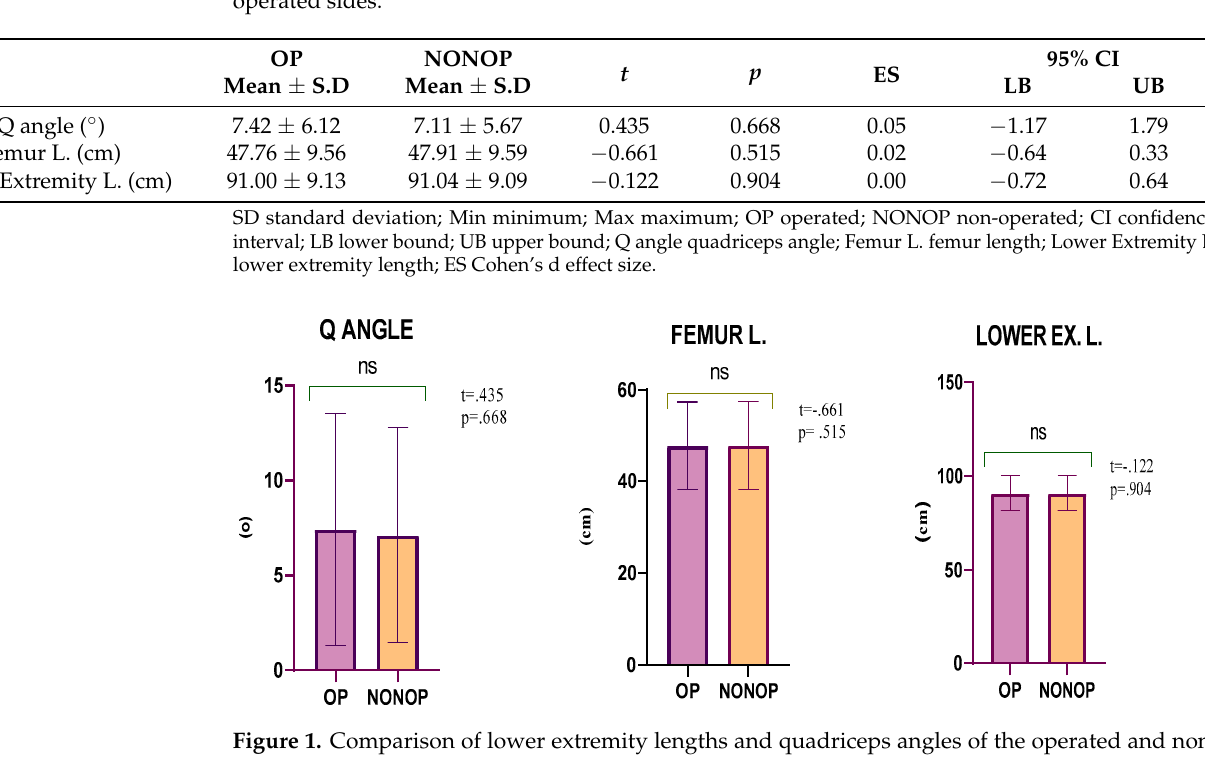
Table 2. Comparison of lower extremity lengths and quadriceps angles of the operated and non- operated sides.